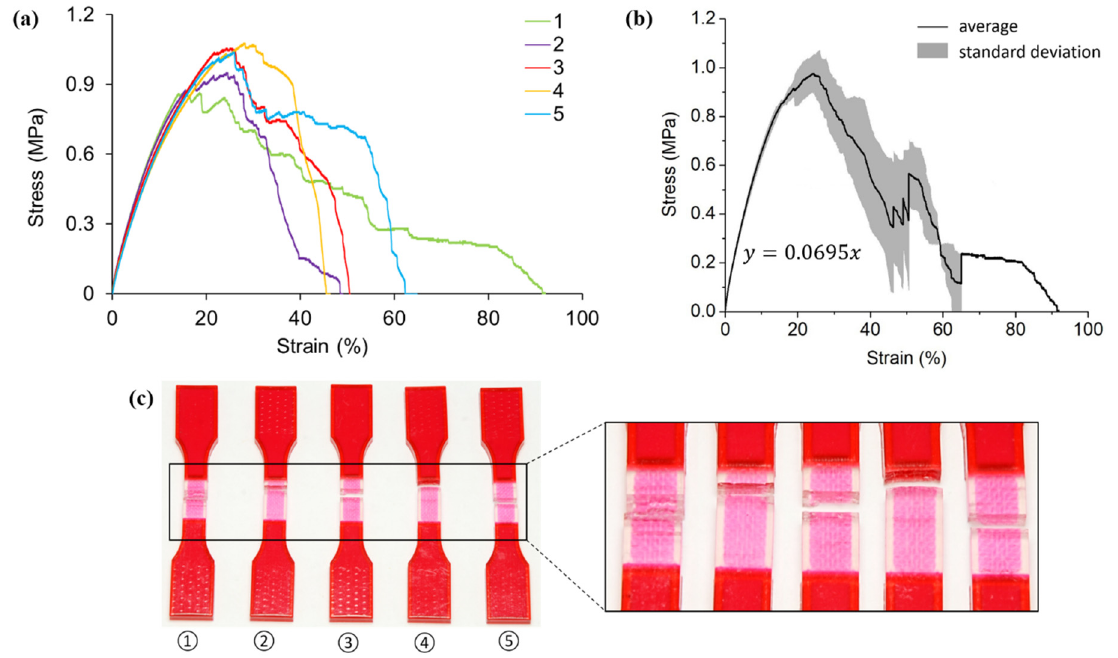
Figure 10. ( a ) Stress-strain curves obtained from tensile testing tests on hybrid case six (mostly vertical second order) samples; ( b ) average tensile stress-strain curve and standard deviation of all five testings; ( c ) pictures of failed tensile samples with zoom-in at the locations of fracture.